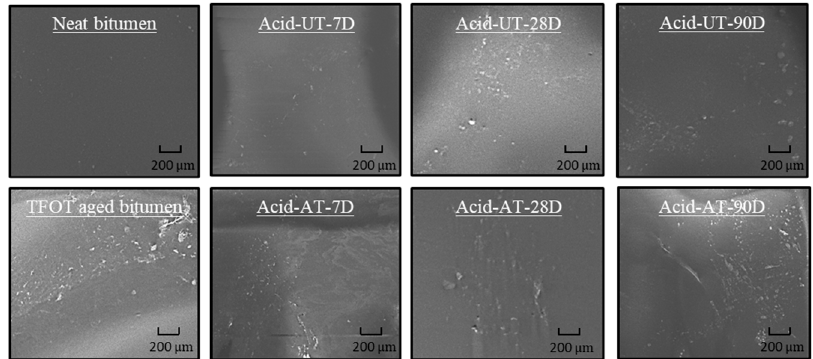
Figure 2. SEM images of the bitumen with and without acid rain erosion.